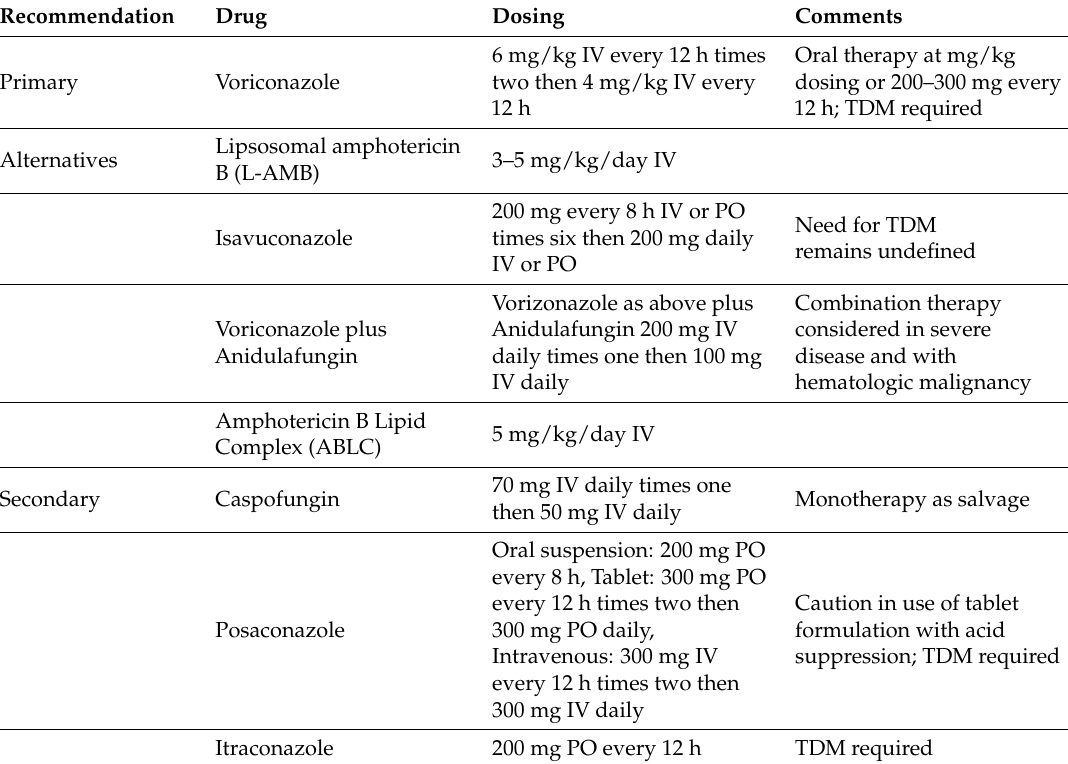
Table 1. Treatment recommendations for invasive